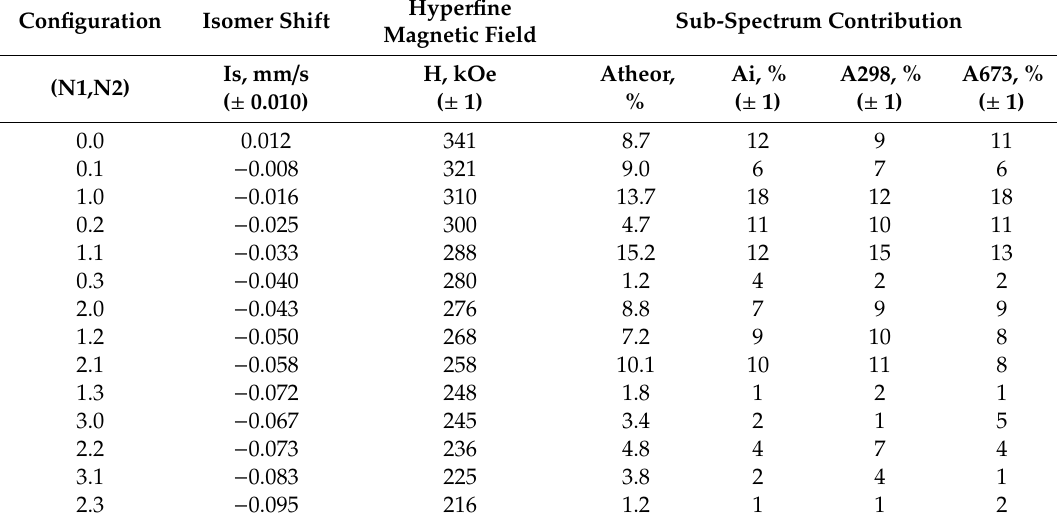
Table 3. Hyperfine parameters* and contributions of subspectra for the Fe-16Cr-Sb alloy. Subspectra contributions are presented for random distribution ( A theor ), initial state ( A i ) and after HPT at 298 K ( A 298 ) and 673 K ( A 673